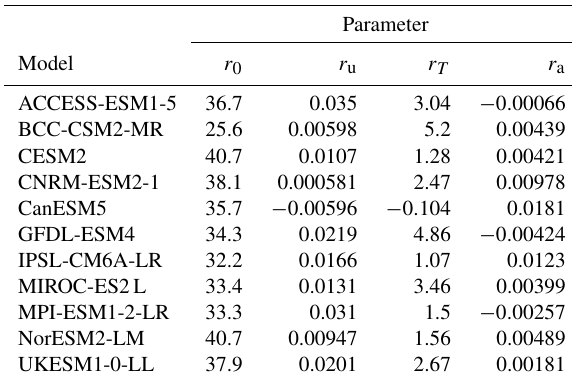
Table 3. Tuned CMIP6 carbon cycle